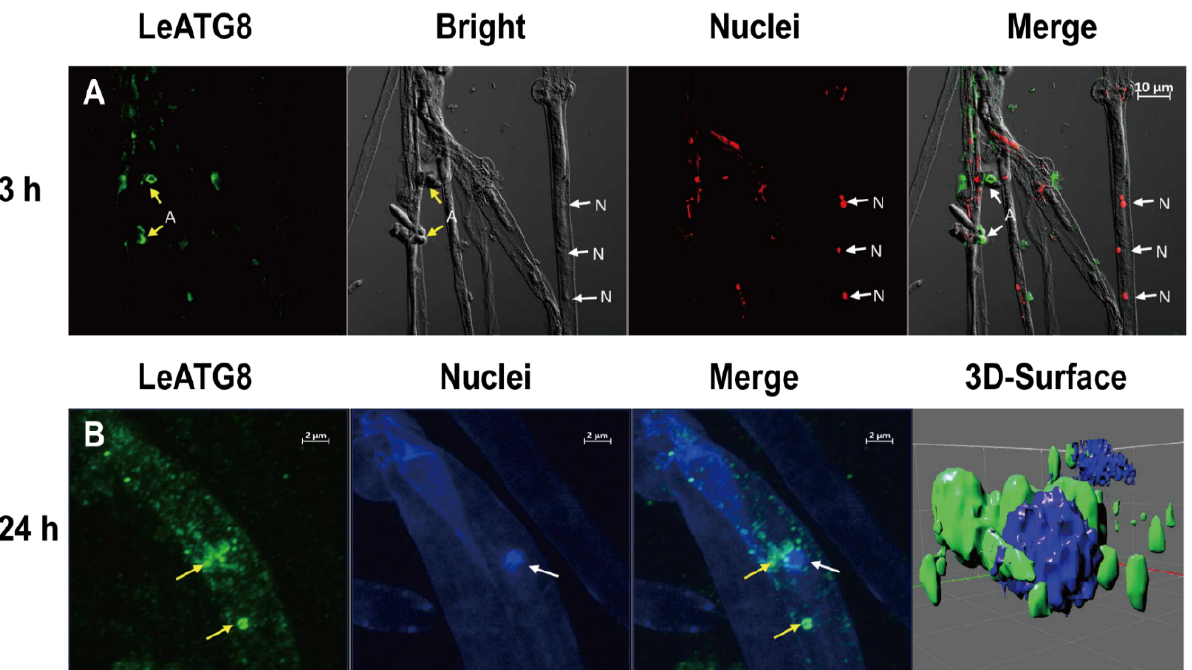
Figure 5. Subcellular localisation of LeATG8 in the mycelia treated with 100 µM H 2 O 2 . ( A ) Immuno fl uorescence of LeATG8-labelled (green) and DAPI-stained (blue) mycelia after 3 h treatment. ( B ) Immuno fl uorescence of LeATG8-labelled (green) and DAPI-stained (blue) mycelia after 24 h treatment. Yellow arrows indicate LeATG8-labelled mycelia. White arrows indicate nuclei. A, autophagosome; N, nuclei.